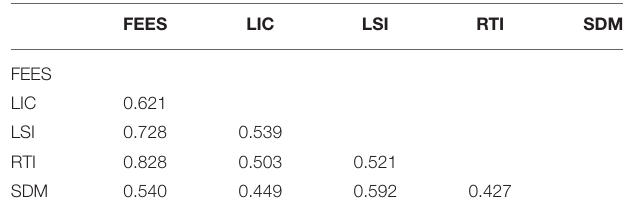
TABLE 2 | Convergent validity. TABLE 3 | Discriminant